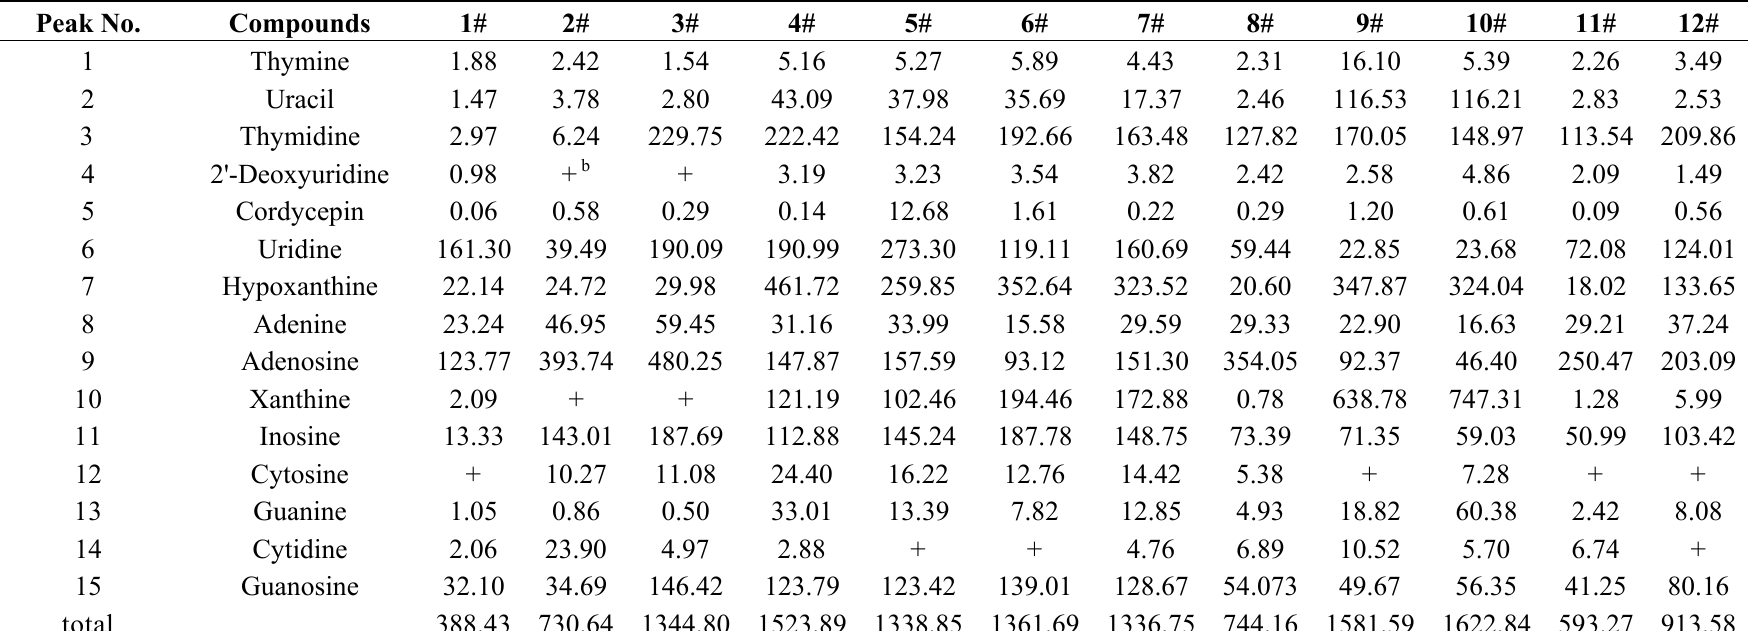
Table 5. Contents a ( μ g/g) of 15 nucleosides and nucleobases in 12 batches of Cordyceps samples (n = 3). Peak